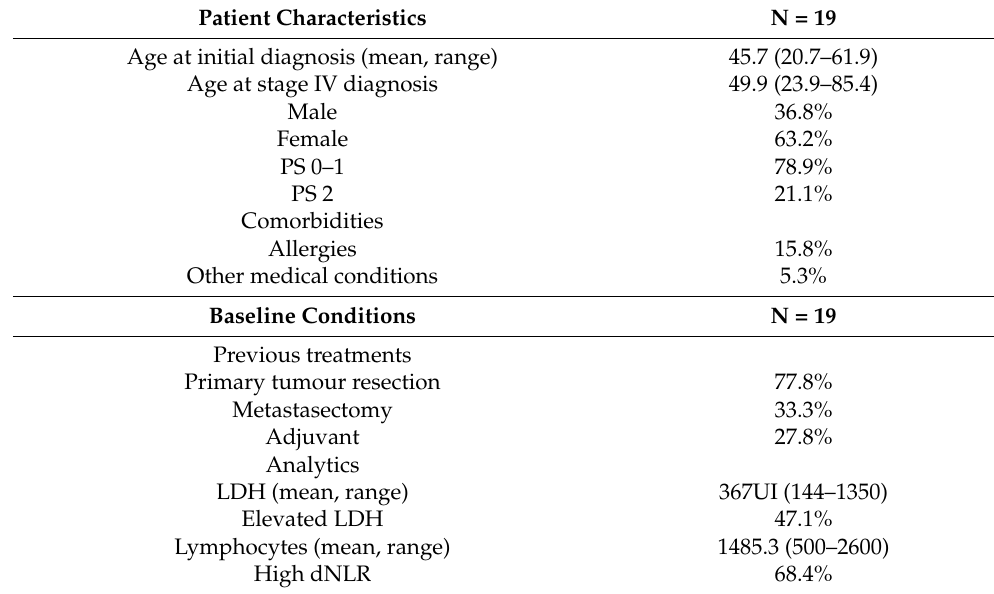
Table 1. Baseline characteristics of